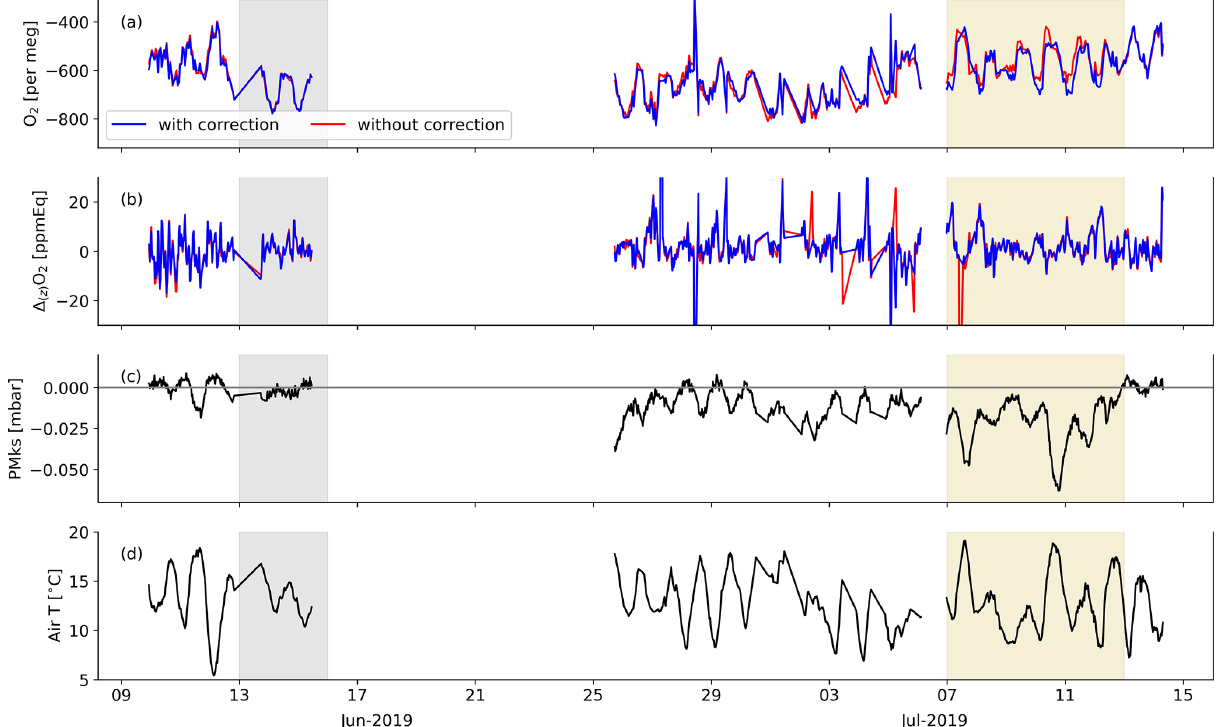
Figure B1. The corrected and uncorrected half-hourly average O 2 concentrations at 23m for the PMKS deviations (a) , together with the corrected and uncorrected gradient of O 2 (b) . The time series for the 2019 measurement period of the PMKS (c) and the air temperature (d) are also shown. The shaded areas indicate the dates that were selected for the two aggregate representative days, i.e. 13 through 15 June (grey) and 7 through 12 July 2019